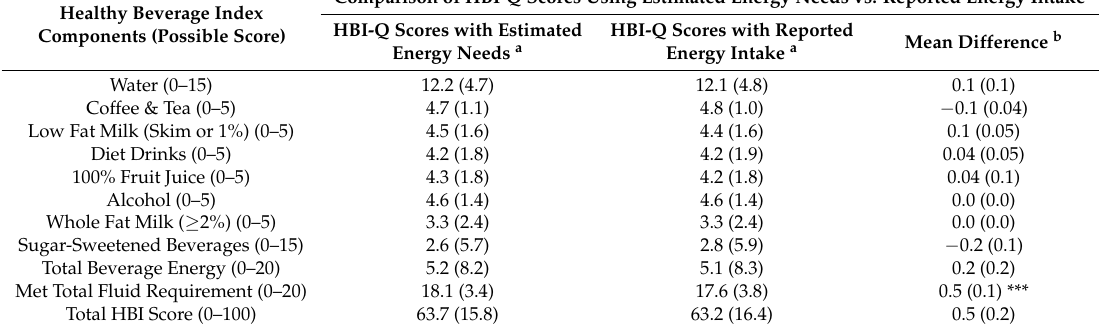
Table 3. Comparison of Healthy Beverage Index (HBI) scores via the HBI-Q using estimated energy needs vs. reported energy intake ( n = 404).